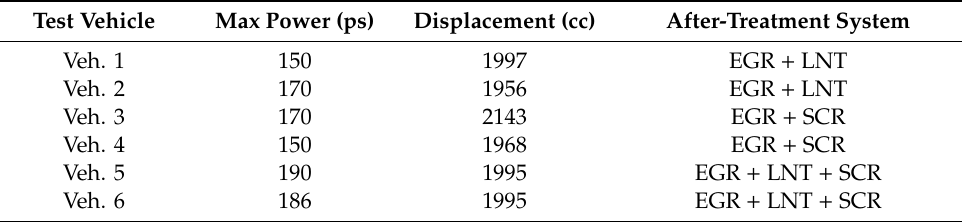
Table 3. Specifications of test